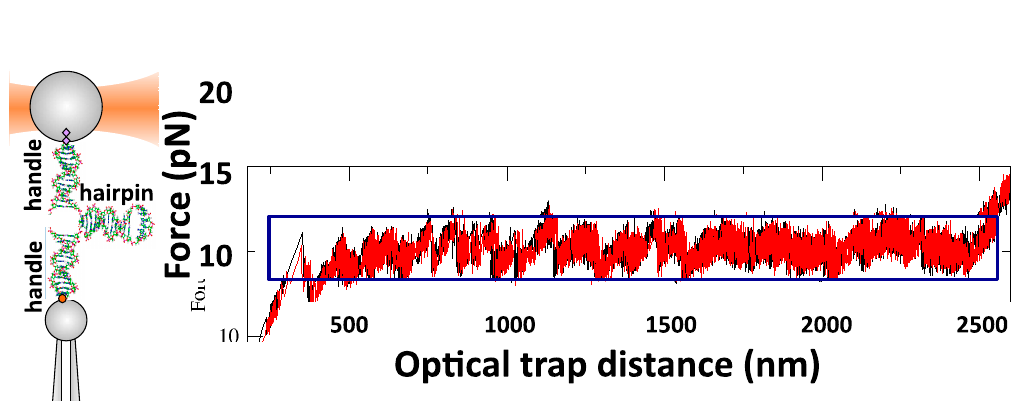
Figure 3. ( Left ) Experimental setup of unzipping experiments. Figure not to scale. ( Right ) Force versus optical-trap position measured in an unzipping (black curve) and re-zipping (red curve) experiment of a DNA hairpin of 2.2 kb at 1kHz acquisition frequency. The force sawtooth-like pattern at 15pN shows the progressive disruption of base pairs along the sequence. The rightmost part of the curve corresponds to the elastic response of the single-stranded DNA. Note the force fluctuations along the curve due to thermal noise and the low hysteresis between unzipping and rezipping curves (black and red data superimpose). The inset below are the same data but filtered to 1Hz bandwith. Data from Hughet et al. [15].